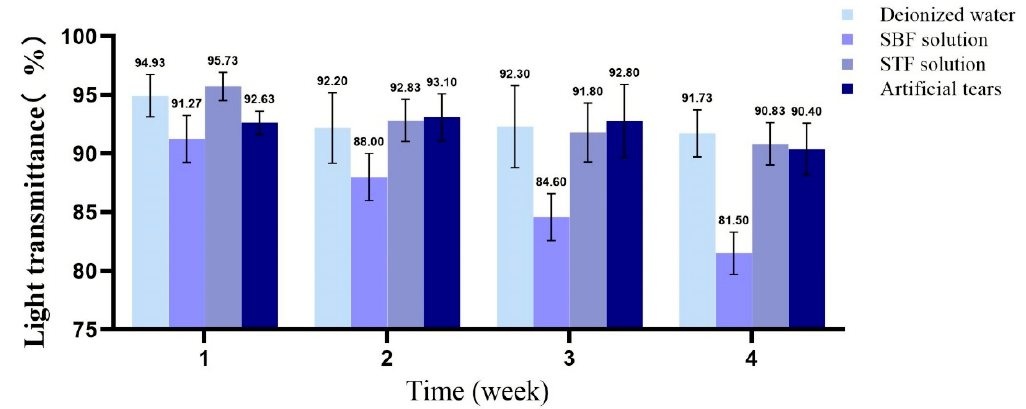
Figure 8. The change in material transmittance at 600 nm with the increase in etching time.